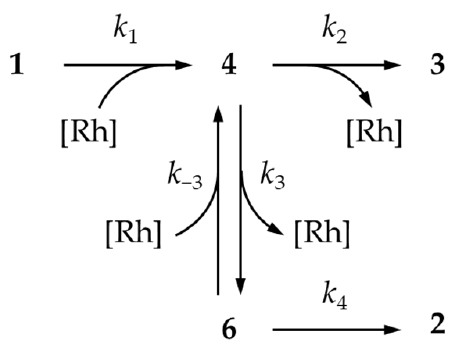
Scheme 3. Schematic representation of the reactions’ mechanism for kinetic interpretation.